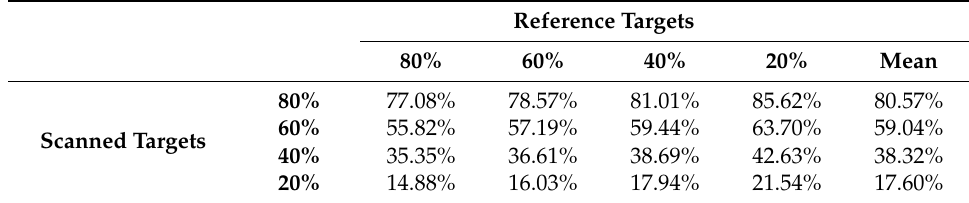
Table 5. Absolute correction results (reflectance) of the four targets at scanning geometries from A to L when different reference targets are